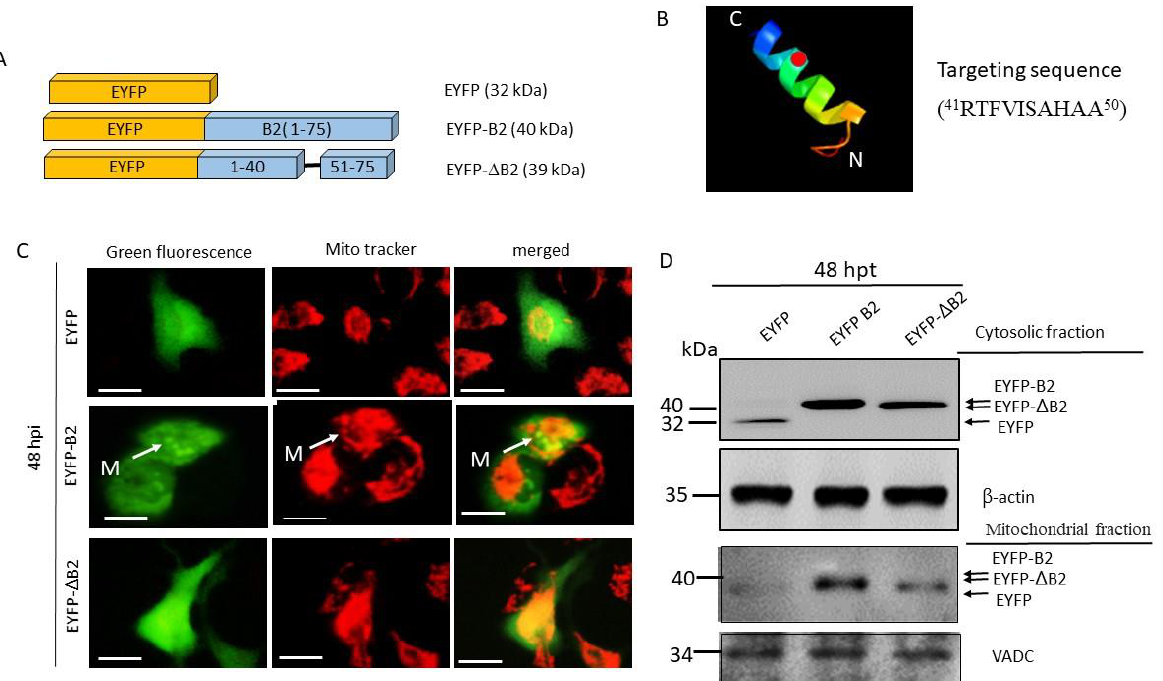
Figure 1. Identification of a novel mitochondria-targeting sequence from B2 in lung cancer cells. ( A ) Mitochondrion-targeting sequences designed using different constructs of wild-type and point mutant forms of RGNNV B2 protein. ( B ) Three-dimensional alpha–helix structure of the full-length RGNNV B2 (1–75 aa) and its mitochondrion-targeting region (36–61 aa). N: N terminus; C: C terminus. ( C ) Trancing EYFP-B2 fusion protein targeted in mitochondria by fluorescence spectrometric analysis 48 h post transfection produces yellow fluorescence in 45% of A549 cells (see Figure S1) but not in cells with EYFP and EYFP- ΔB2 (del 41 RTFVISAHAA 50) ). Green, fluorescent, Mitotracker staining and merged images of EYFP, EYFP-B2, and EYFP- ΔB2 transfected cancer cells 48 h post transfection, with the EYFP-B2 fusion protein targeted in mitochondria shown in yellow and indicated by arrowheads (white bar: 10 μm). M: mitochondria. ( D ) Western blot analysis of EYFP shows the protein distribution in the mitochondrial and cytosolic fractions at 48 h post transfection.